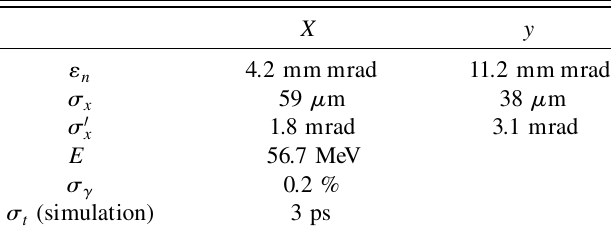
TABLE II. Measured electron beam parameters at the inter- action point, including the normalized rms emittance, the rms spot size, divergence, energy, and energy spread. The electron bunch length was determined from PARMELA simulations of the electron beam production and